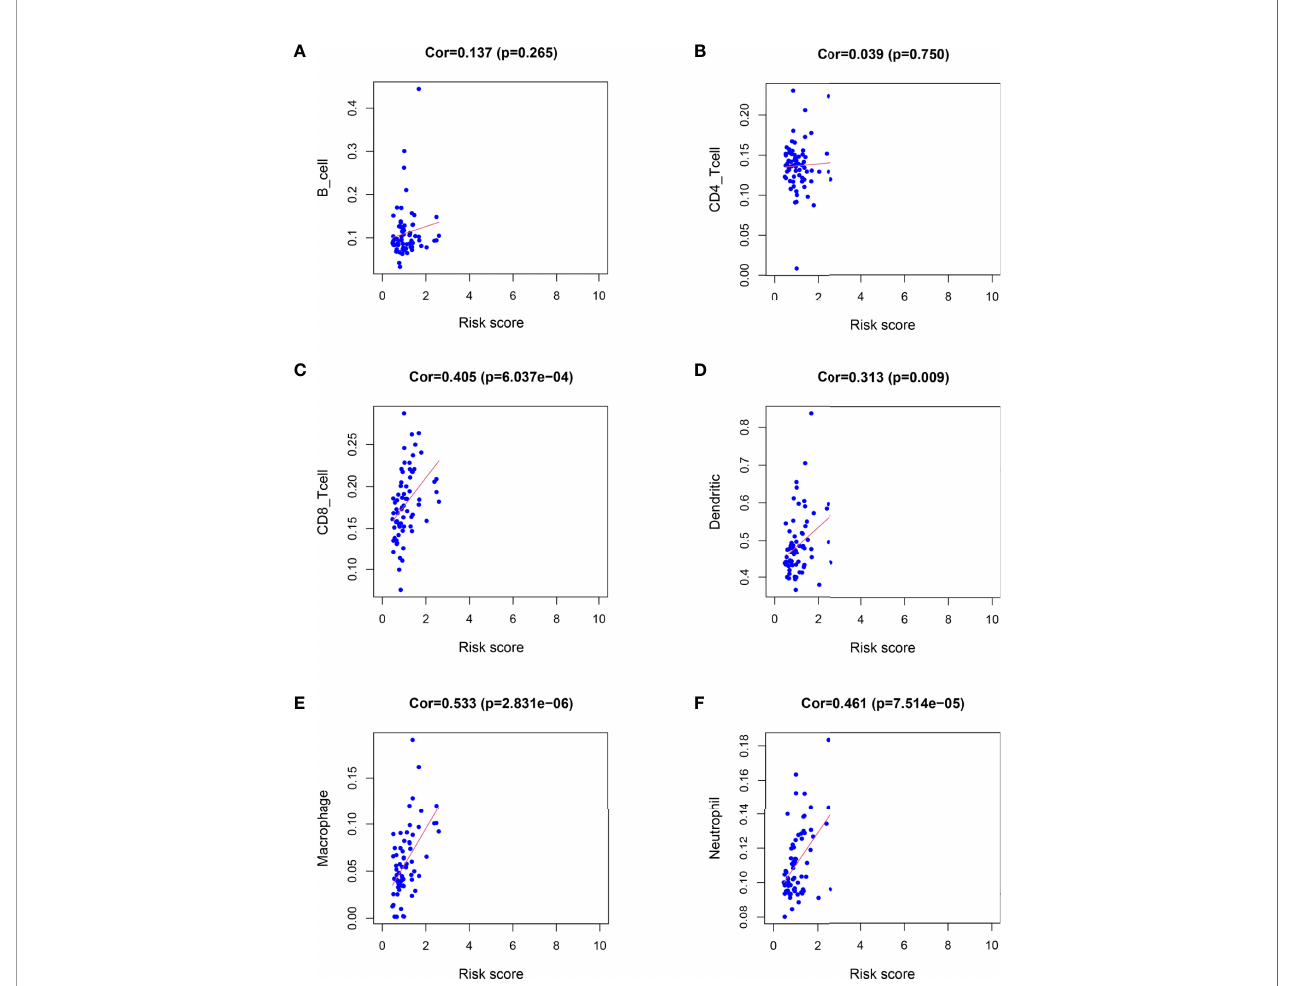
FIGURE 8 | Relationship between immune cell in fi ltration and the risk score of the prognostic model. (A – F) was shown the correlationship between B cell, CD4 T cell, CD8 T cell, Dendritic cell, Macrophage, Neutrophil and risk score of prognostic